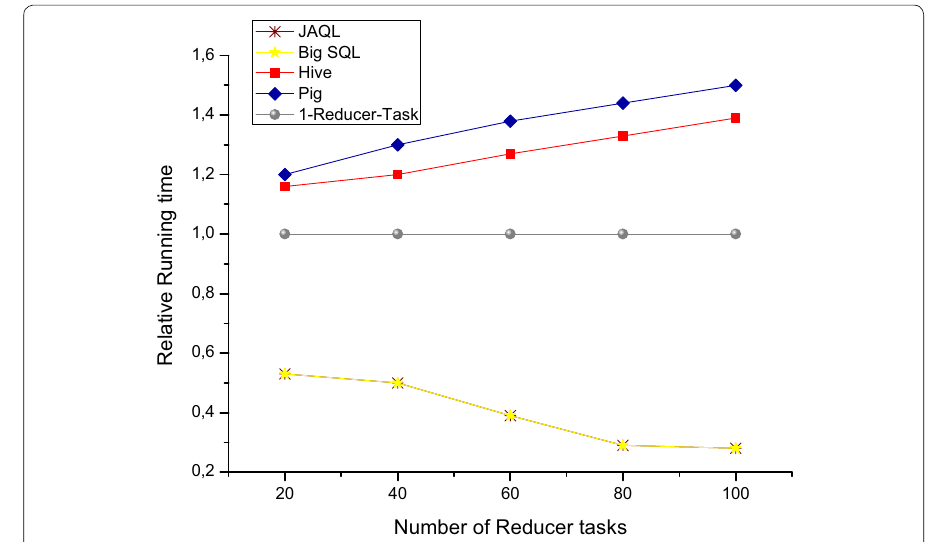
Fig. 13 Controlling the number of reducers: WordCount